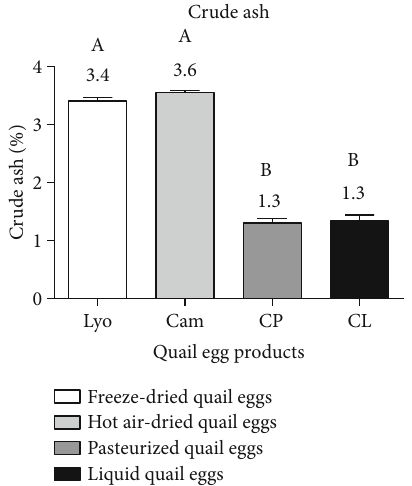
Figure 7: Crude ash content of liquid (CL), freeze-dried (Lyo), hot air-dried (Cam), and pasteurized (CP) quail eggs.